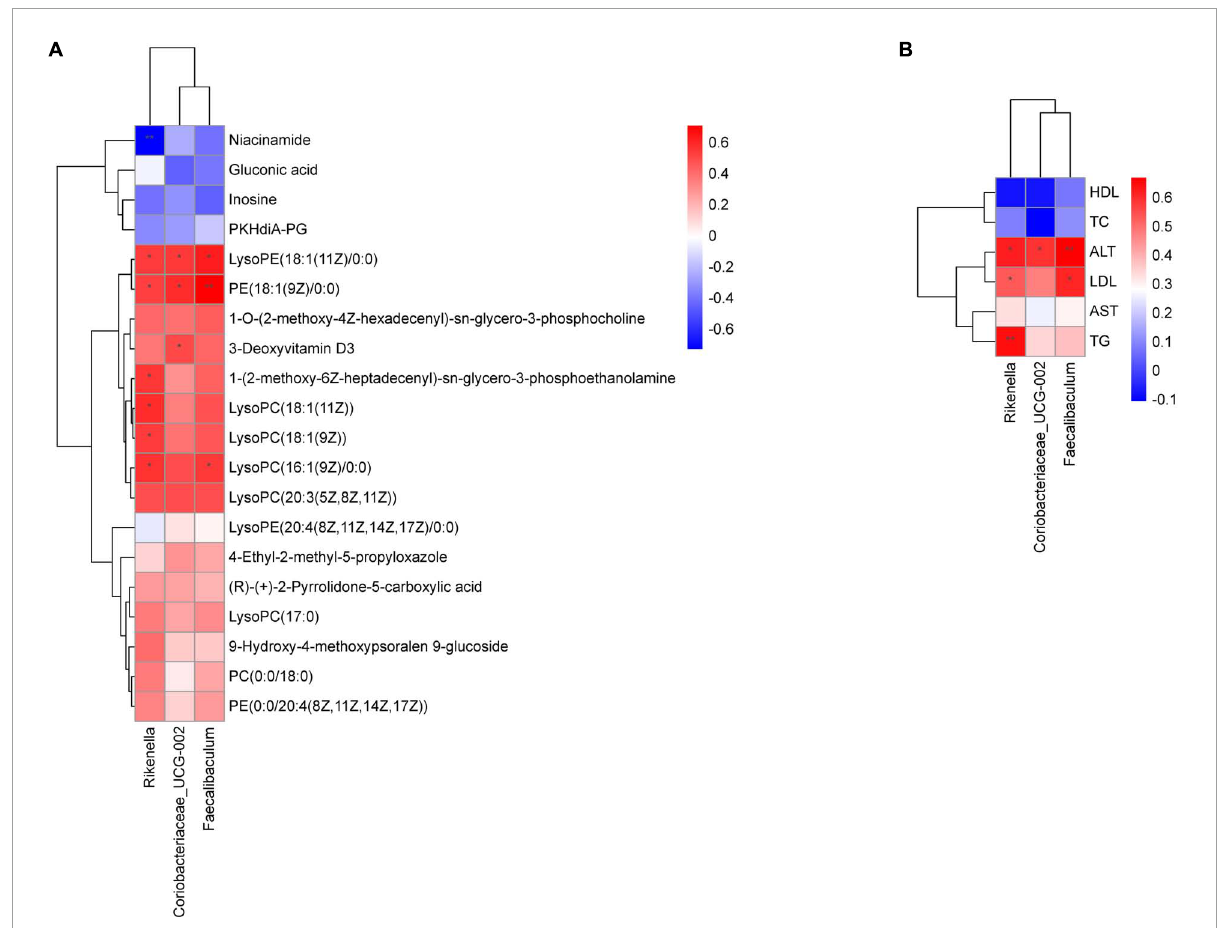
FIGURE9 Correlation analysis of physiological data, liver metabolomics and gut microbiota. (A) Heatmap of gut microbiota constituents and differentially abundant metabolites; (B) heatmap of gut microbiota constituents and physiological data. X -axis represents the gut microbiota with differential abundance. Y -axis represents the differential metabolites (A) and physiological indexes (B) . Grids in red indicate positive correlations (correlation analysis value more than 0.1), while grids in blue indicate negative correlations (correlation analysis value less than –0.1), * p < 0.05, ** p <